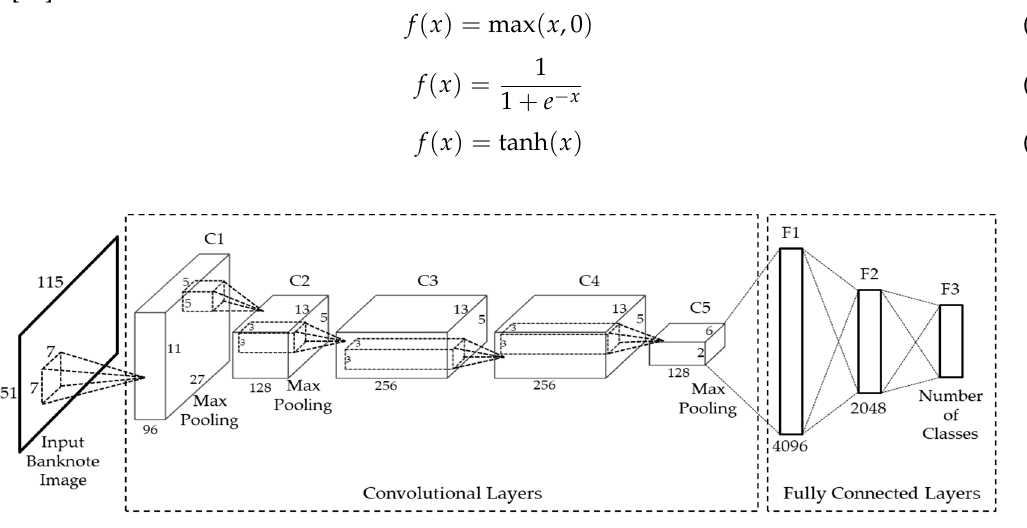
Figure 3. Convolutional neural network (CNN) architecture used in our proposed method. Table 2. Structure of CNN used in our proposed method (unit: pixel).